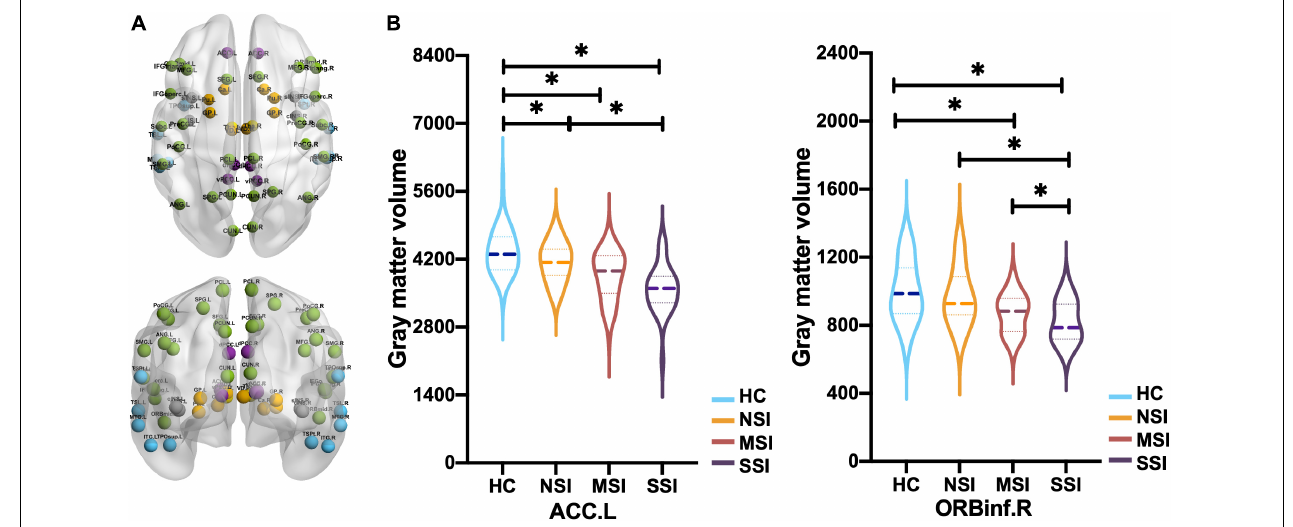
FIGURE 2 | Comparison of gray matter volume (GMV) of 58 brain regions in CON. (A) Frontal and parietal lobe (green), cingulate gyrus (purple), temporal lobe (blue), insula (gray), basal ganglia (orange), and thalamus (gold) in CON (58 regions). (B) The left anterior cingulate gyrus (ACC.L) of three major depressive disorder (MDD) groups has a smaller GMV than the HC, and NSI > SSI. The right orbital inferior frontal gyrus (ORBinf.R), MSI, and SSI have smaller GMV than HC, and NSI > MSI > SSI [ ∗ p < 0.05, false discovery rate (FDR)]. Healthy group (HC), no suicidal ideation (NSI), mild suicidal ideation (MSI), and severe suicidal ideation